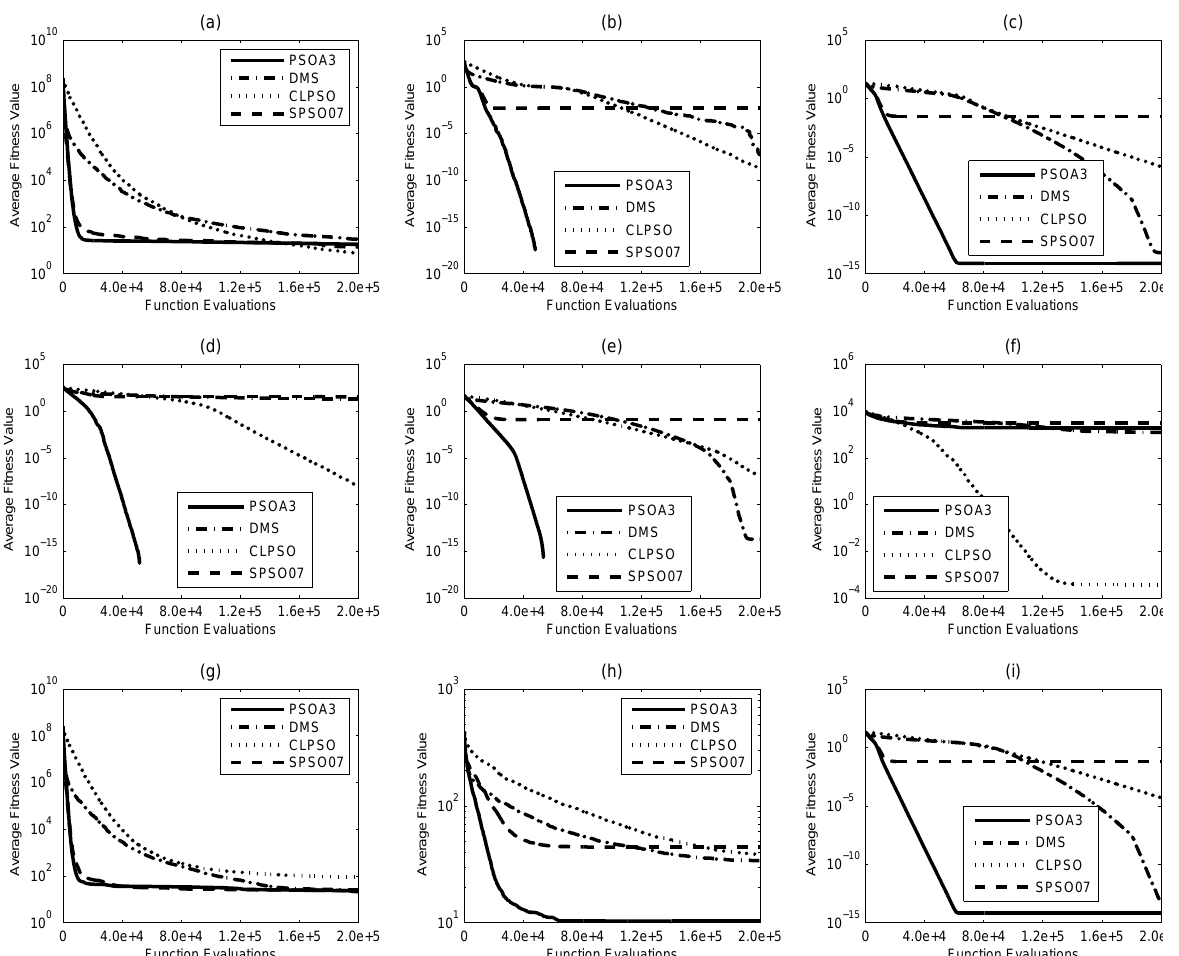
Figure 5: Average best fitness value for PSOA3, DMS-PSO,CLPSO and SPSO07 on the test functions.(a) f 1 . (b) f 2 . (c) f 3 . (d) f 4 . (e) f 5 . (f) f 6 . (g) f 7 . (h) f 8 . (i) f 9 . mutation and inertia weight